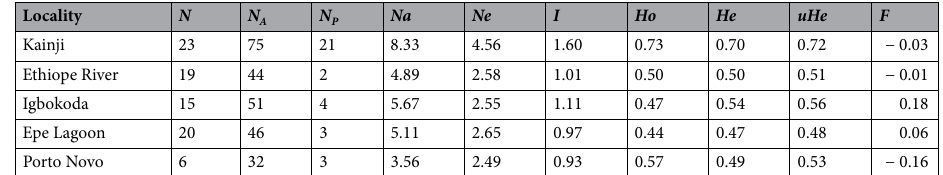
Table 1. Genetic diversity estimates for H. niloticus from five localities in Nigeria and Benin. N , number of individuals; N A , number of alleles; N P , number of private alleles; Na , average number of alleles per locus; Ne , average number of effective alleles per locus; I , Shannon’s information index; Ho , mean observed heterozygosity; He , mean expected heterozygosity; uHe , mean unbiased expected heterozygosity; F , inbreeding coefficient (fixation